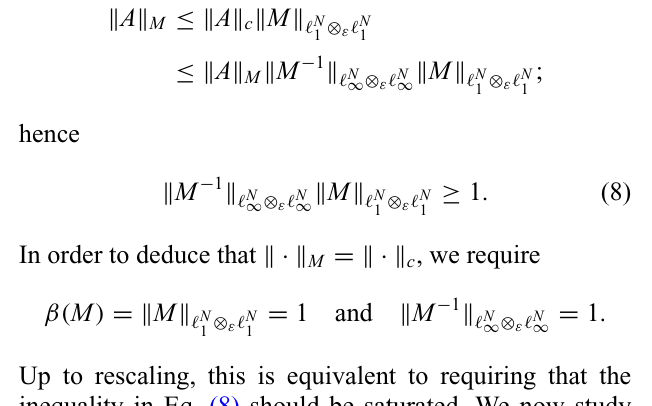
) (cid:2) , σ , σ , X Y Z c Bell 3322